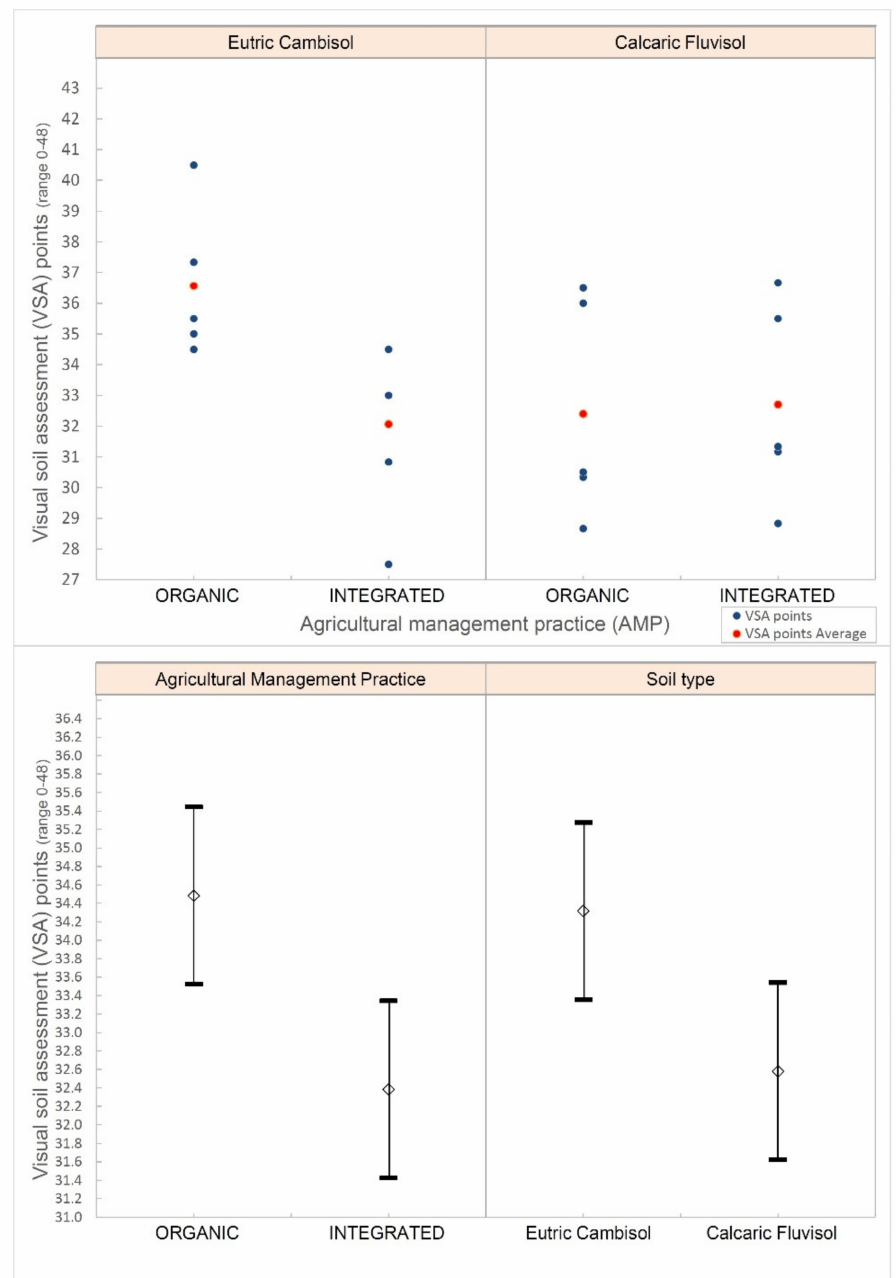
Figure 3. Graphic presentation of the VSA points concerning the agricultural management practice type for different soil types (red dots represent the blue dots’ mean). The box plot shows the visual soil assessment score (VSA) means by management system (organic (ORG) or integrated (INT)), or by soil type. The differences for management are significant at the 95% confidence level, tested by Tukey’s honestly significant difference (HSD) procedure